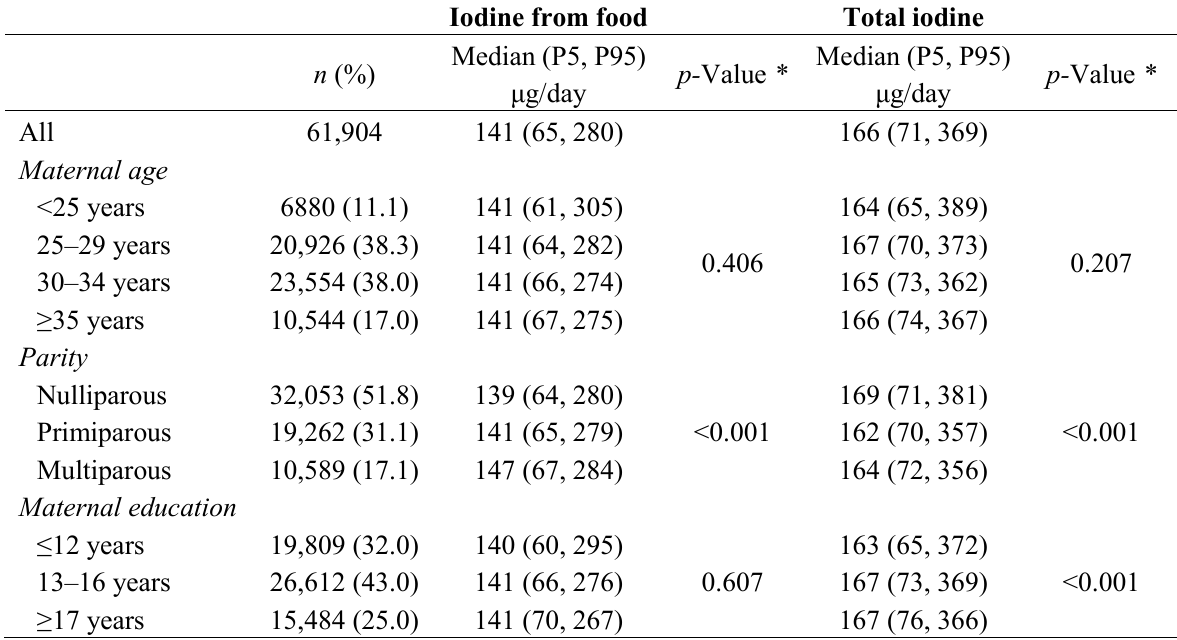
Table 2. Iodine intake, median and range (5th percentile, 95th percentile) by maternal